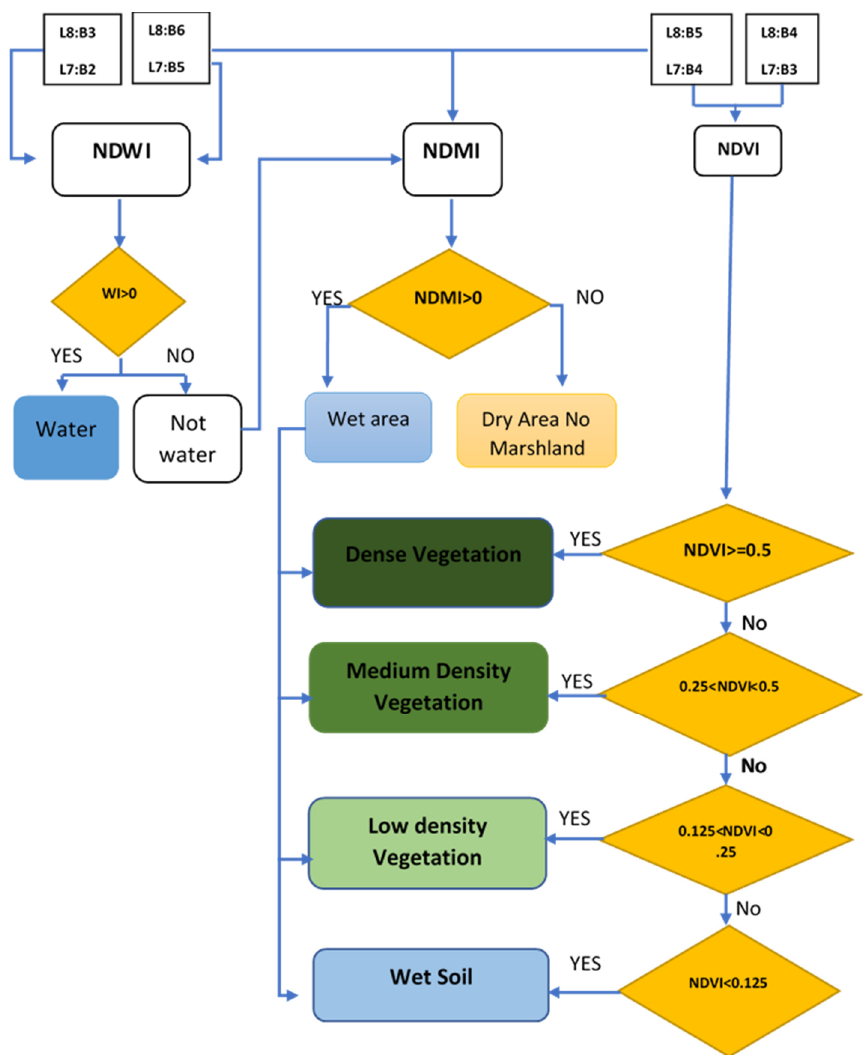
Figure 4. Method for identifying marshland extents, open waters, and vegetated areas.